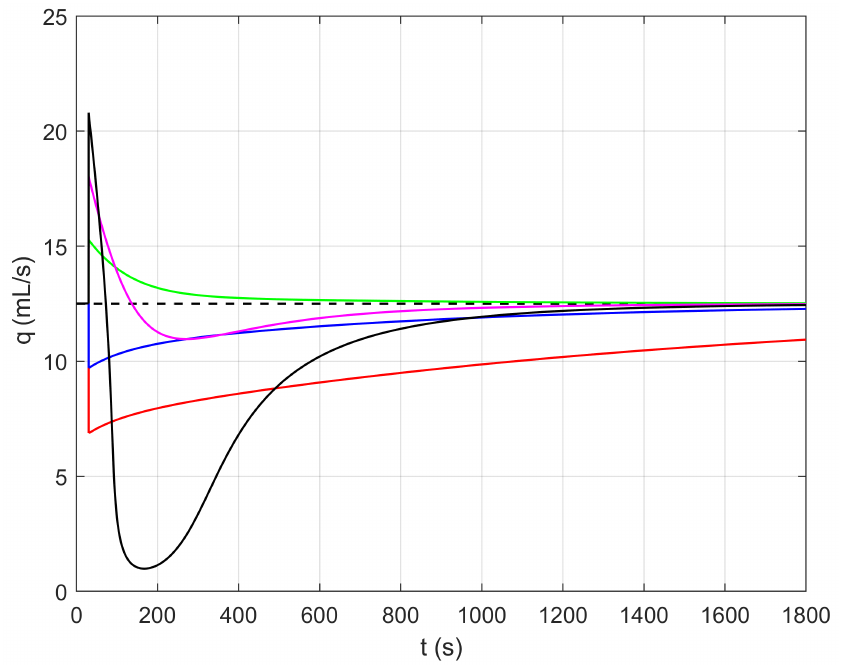
Figure 6. Sensitivity of arterial–arteriolar blood flow rate q autoregulation response to changes in systemic arterial pressure steady state values (solid red line for a step decrease to P a ( t ) ≡ 60 mmHg, κ 1 = 6.5358 × 10 − 4 , κ 2 = 0.01, M 1 = 0.6568, M 2 = 4.2969 × 10 − 4 ; solid blue line for a step decrease to P a ( t ) ≡ 80 mmHg, κ 1 = 0.0012, κ 2 = 0.01, M 1 = 0.2490, M 2 = 3.0474 × 10 − 4 ; solid green line for a step increase to P a ( t ) ≡ 120 mmHg, κ 1 = 0.0019, κ 2 = 0.01, M 1 = 0.1643, M 2 = 3.0938 × 10 − 4 ; solid magenta line for a step increase to P a ( t ) ≡ 140 mmHg, κ 1 = 0.0023, κ 2 = 0.01, M 1 = 0.2942, M 2 = 6.7020 × 10 − 4 ; solid black line for a step increase to P a ( t ) ≡ 160 mmHg, κ 1 = 0.0026, κ 2 = 0.01, M 1 = 0.3984, M 2 = 0.001; dashed line for the reference value q = q n